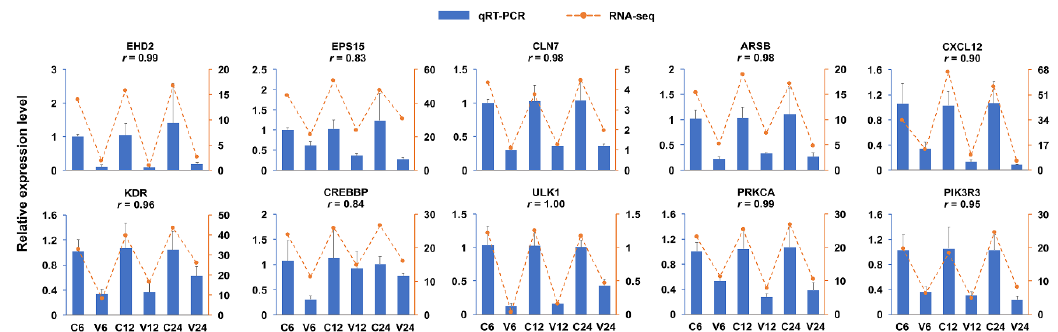
Figure 6. Validation of differentially expressed target genes of the DEmiRs (DETGs) in the immune-related network. The expressions of 10 DETGs enriched in 5 immune-related pathways were tested by qRT-PCR and compared with that obtained by RNA-seq. The results are shown as means ± standard deviation ( n = 3). For each DETG, the correlation coefficient ( r ) between the results of qRT-PCR and RNA-seq is indicated.